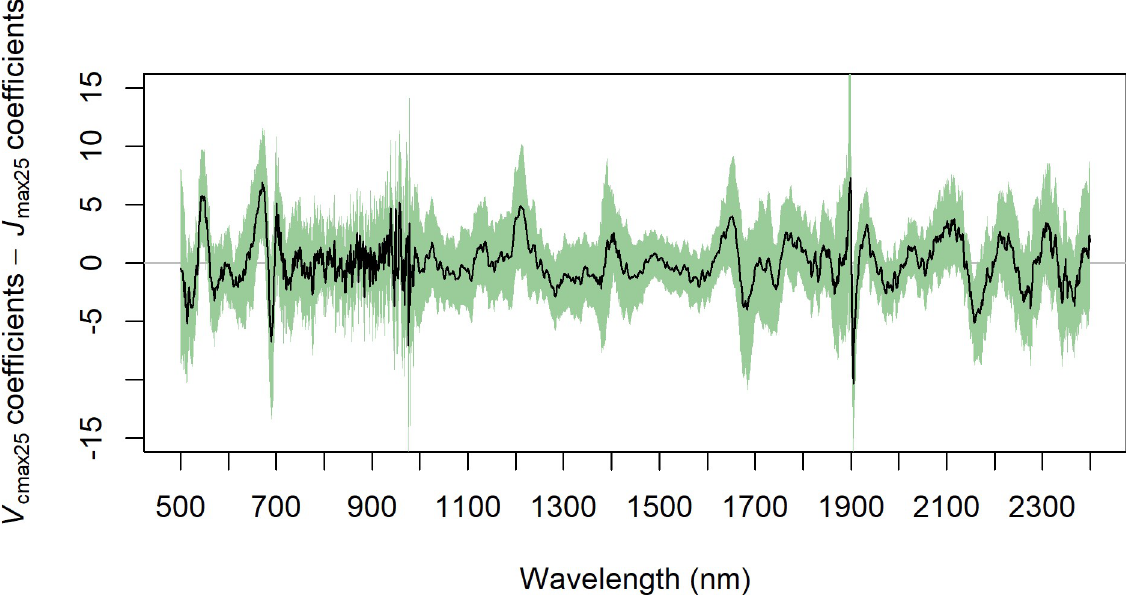
Fig 5. Difference between V cmax25 and J max25 PLSR coefficients. The black line corresponds to the mean of the difference and the green band corresponds to 95% of the values. The areas where the green band does not overlap with the grey horizontal line highlight wavelengths where the difference is statistically different from